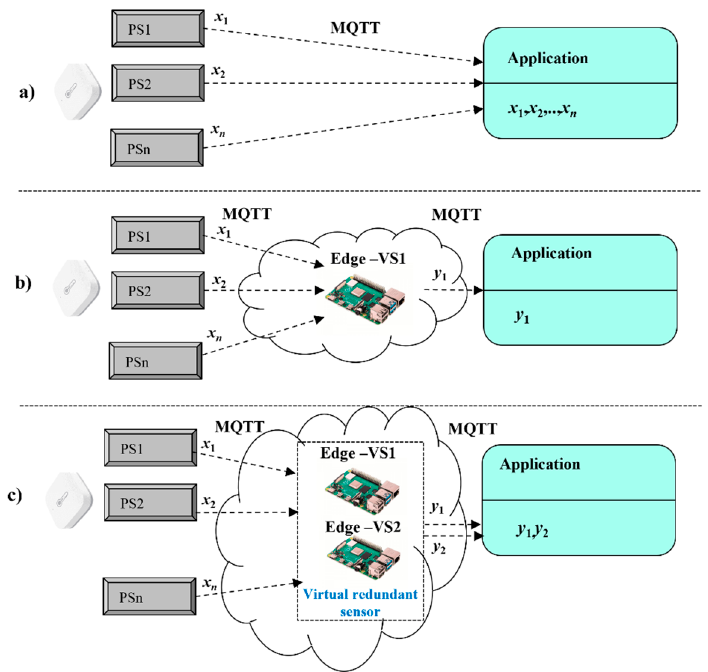
Figure 1. Different models for safety-related applications and sensors ( a ) classical model, ( b ) original model and ( c ) extended model.